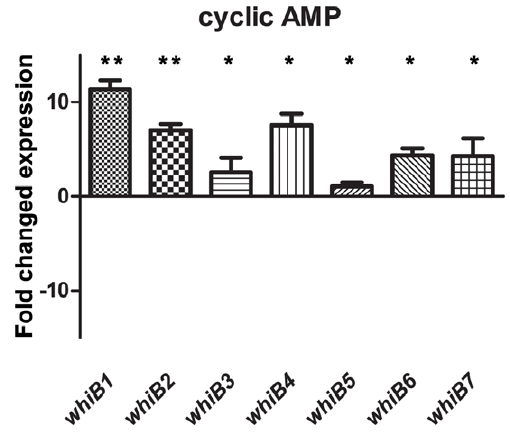
Figure 3. Effect of nitric oxide on whiB1-7 expression. M.tb CDC1551 was grown for 12 h in the presence of 500 m M DETA-NO. whiB3, whiB6 and to a lesser extent, whiB7 were upregulated.